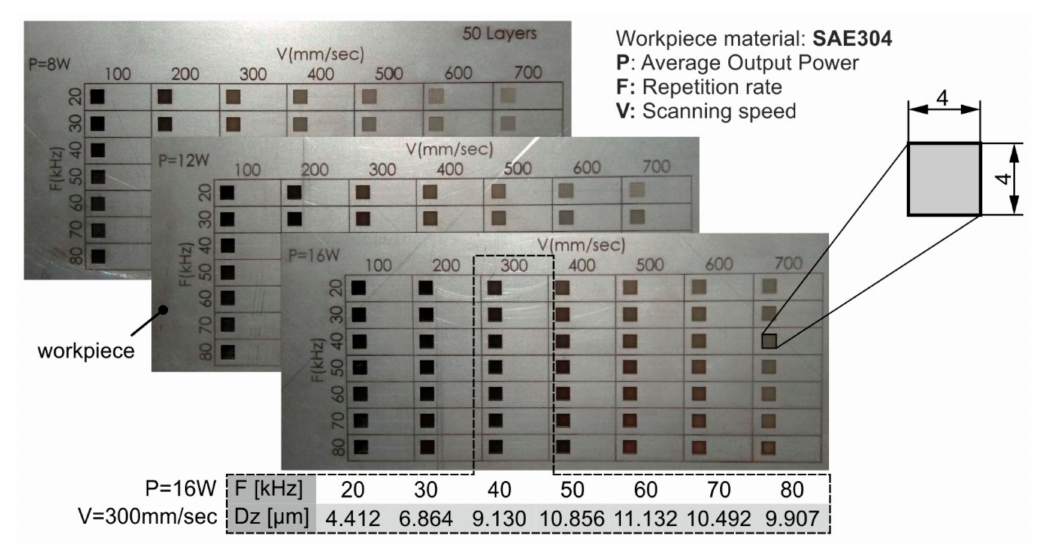
Figure 4. Experimental